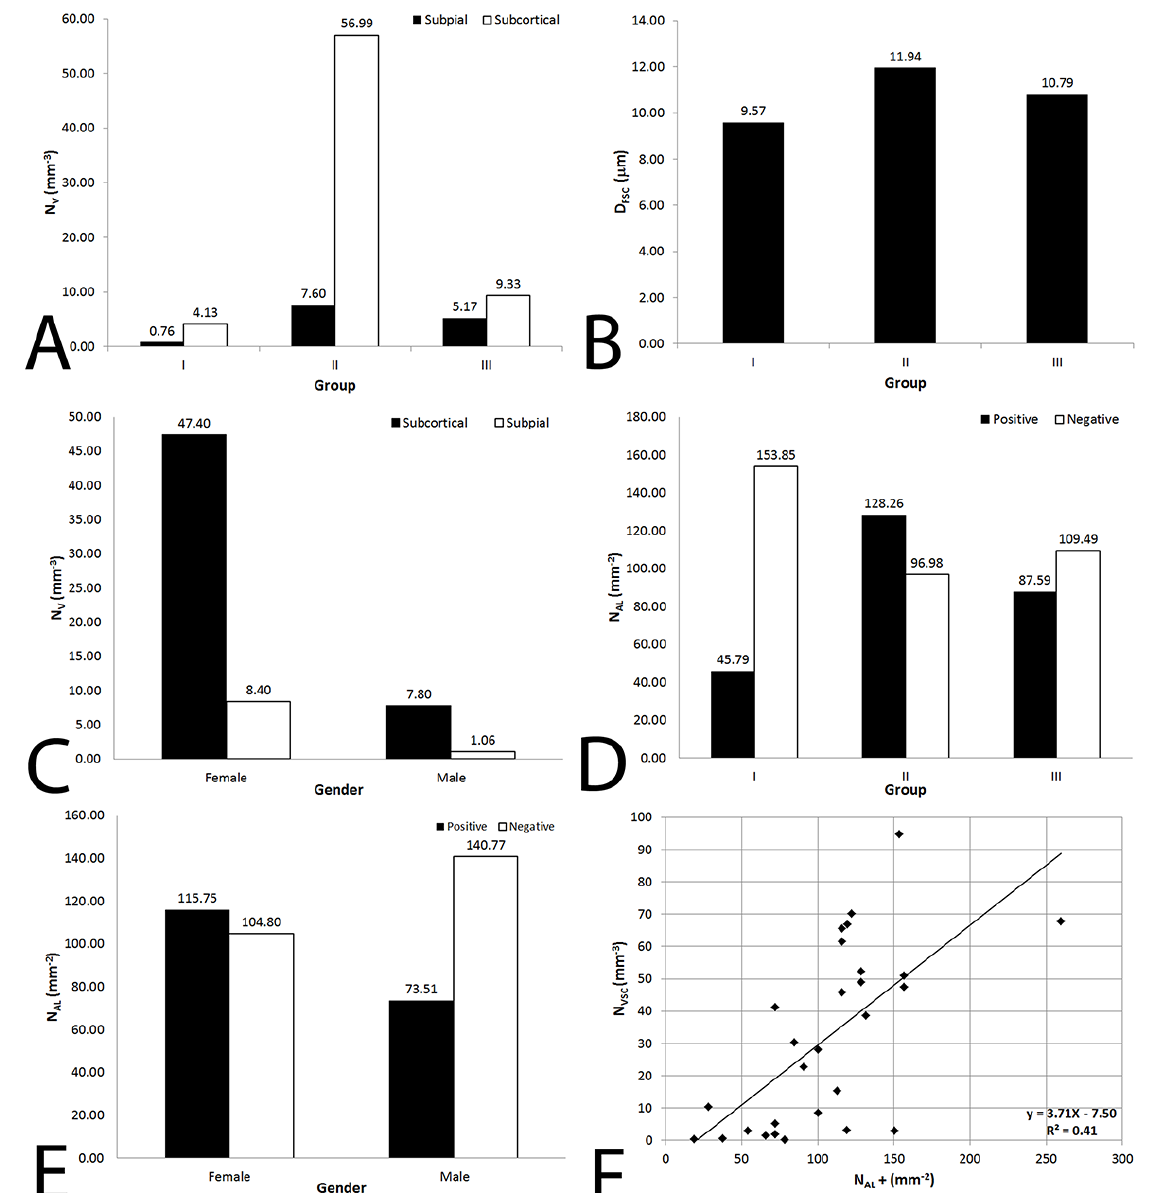
Figure 3. (A) Numerical density of subpial and subcortical CA in groups obtained during cluster analysis; (B) Feret’s diameter of subcortical CA in the same groups (C) Numerical density of subpial and subcortical CA in male and female cases (D) Number of lipofuscin-bearing and number of lipofuscin free neurons in the groups obtained during cluster analysis (E) Number of lipofuscin-bearing and lipofuscin-free neurons in male and female cases (F) Scatter plot with regression line of the number of lipofuscin-bearing neurons as a predictor and numerical density of subcortical CA as outcome